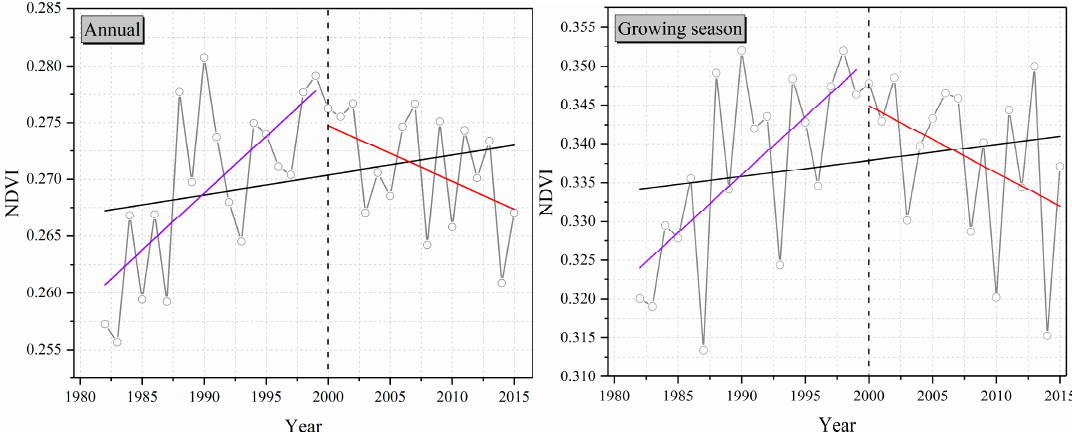
Figure 9. Changes of the annual ( left ) and growing season ( right ) NDVI.